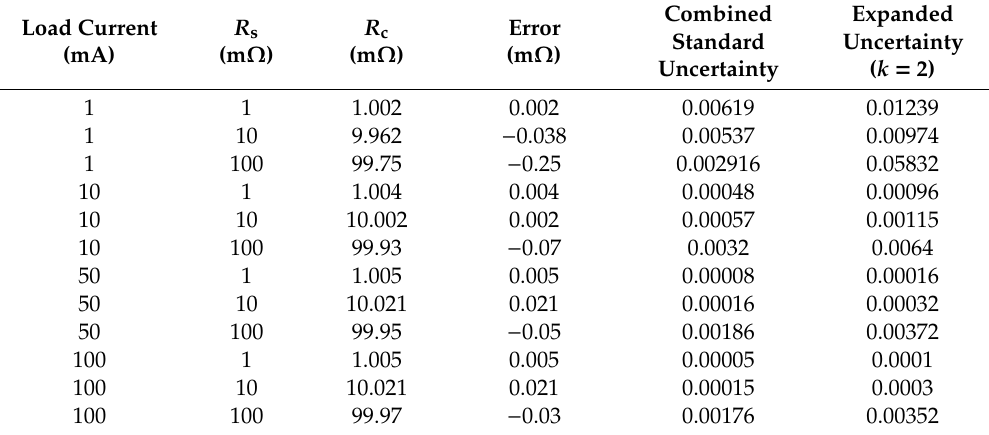
Table 2. Measurement results and corresponding expanded uncertainty. (standard resistance of 1 m Ω , 10 m Ω and 100 m Ω